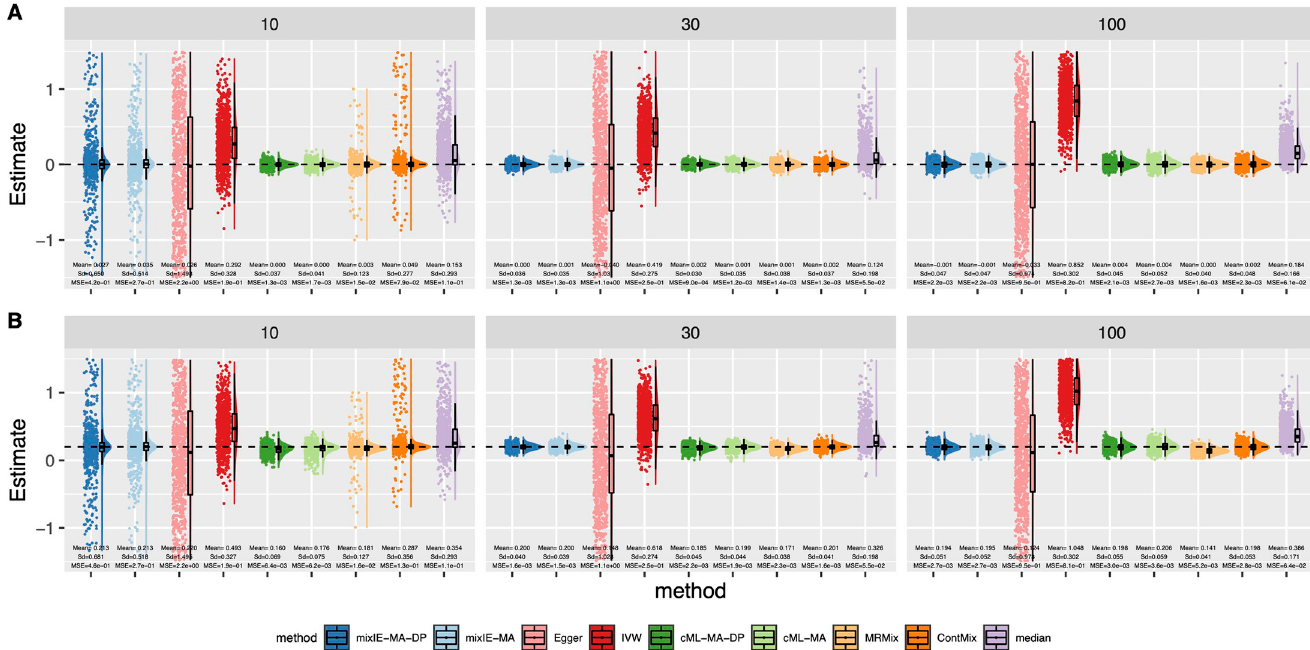
Fig 3. Simulation results with directional pleiotropy and InSIDE satisfied. Empirical distributions of the estimates of the causal effect θ by the methods with n = 50000 and 70% invalid IVs. A: θ = 0. B: θ = 0.2.